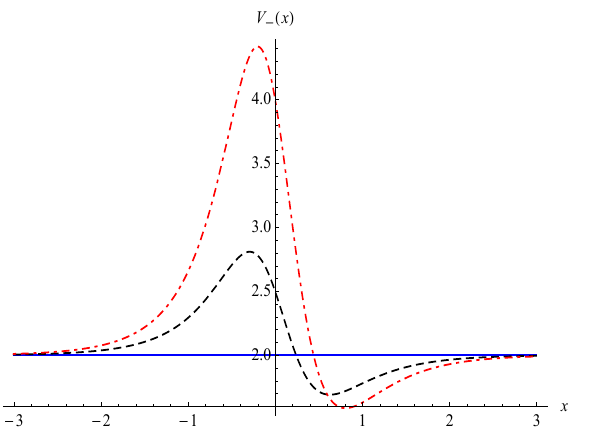
Figure 5 . Plot of V (cid:0) ( x ) for B = 0 (solid line), B = 0 : 5 (dashed line), and B = 1 : 0 (dotdashed line),